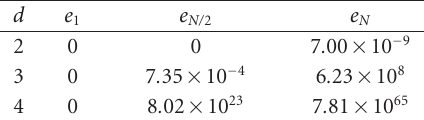
Table 6.4. Approximate error for Example 6.1.